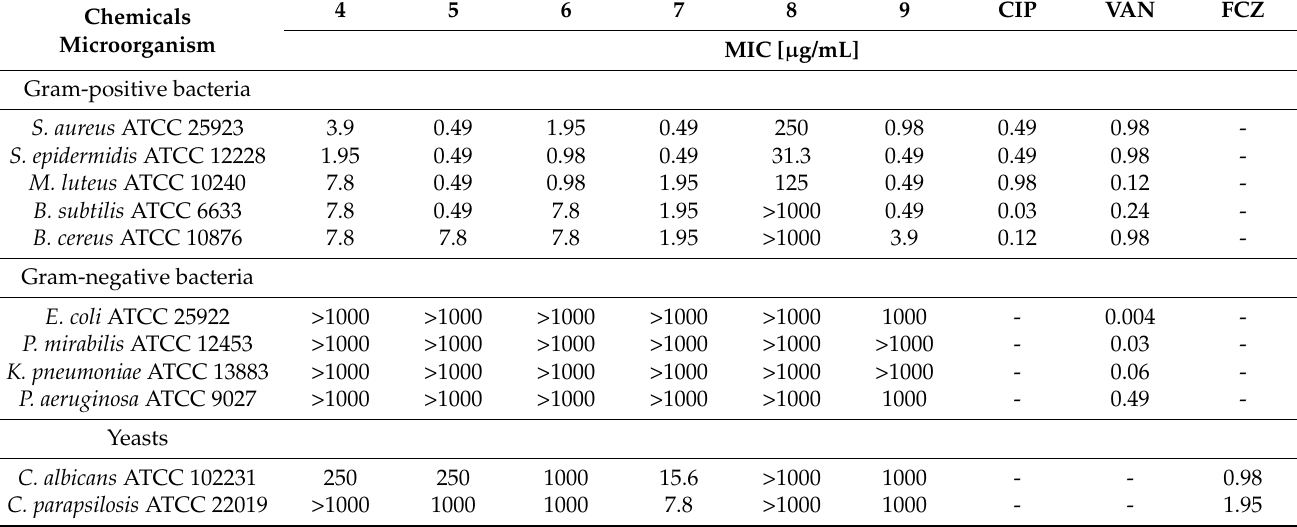
Table 2. In vitro antimicrobial activity against Gram-positive bacteria, Gram-negative bacteria, and fungi of compounds 4 – 9 .